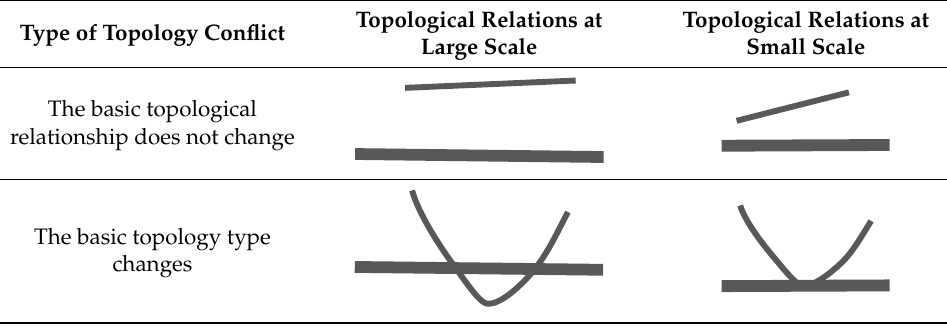
Table 1. Types of topology conflicts in cartographic generalization.